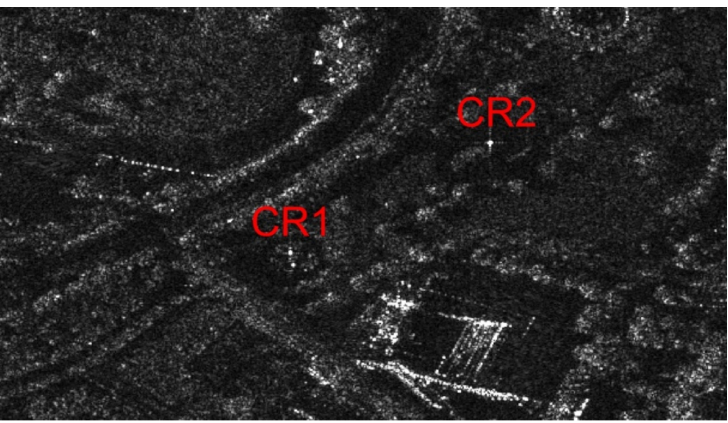
Figure 1. Position of the corner reflectors CR-1 and CR-2 used in the